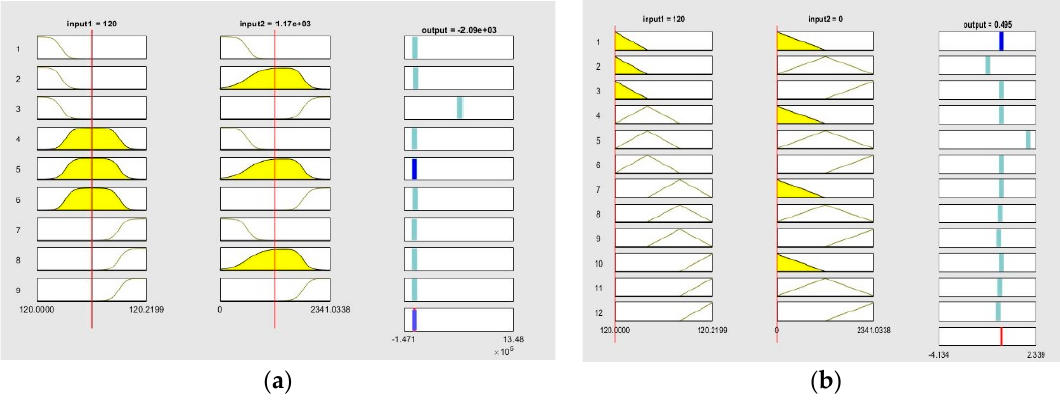
Figure 20. Surface plot. ( a ) P-F ANFIS; ( b ) Q-V ANFIS.